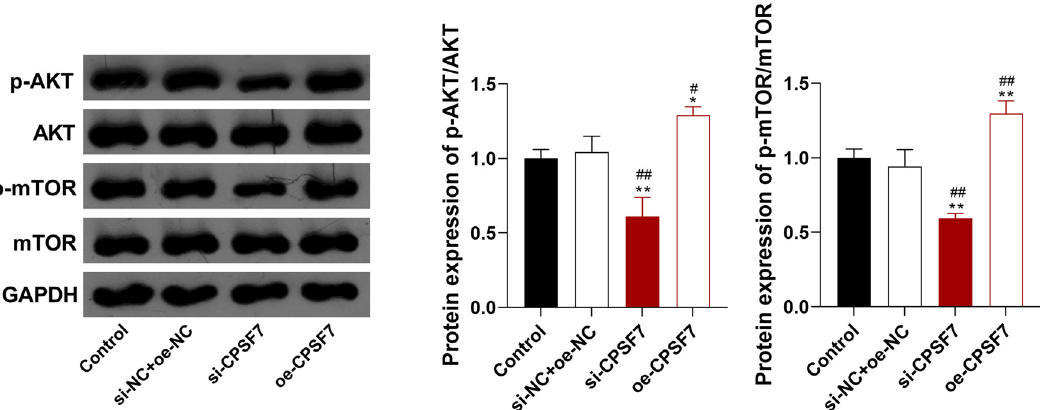
Figure 3: The regulatory role of CPSF7 on the AKT/mTOR signaling pathway in LUAD cells. A549 cells were stably transfected with si - CPSF7 or oe - CPSF7 . The protein expression of p - AKT/AKT and p - mTOR/mTOR was detected by Western blotting. Each experiment was repeated 3 times ( n = 3 ) . * P < 0.05, ** P < 0.01 vs Control; # P < 0.05, ## P < 0.01 vs si - NC + oe -